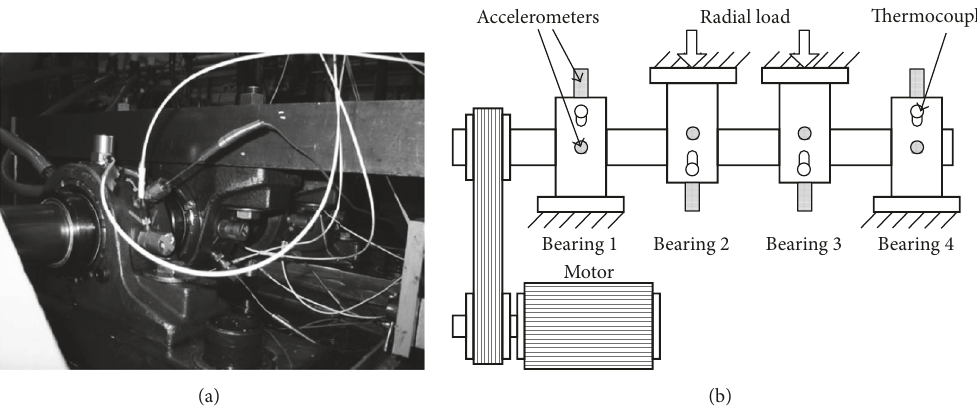
Figure 2: Bearing test rig and sensor placement illustration: (a) bearing test rig; (b) sensor placement